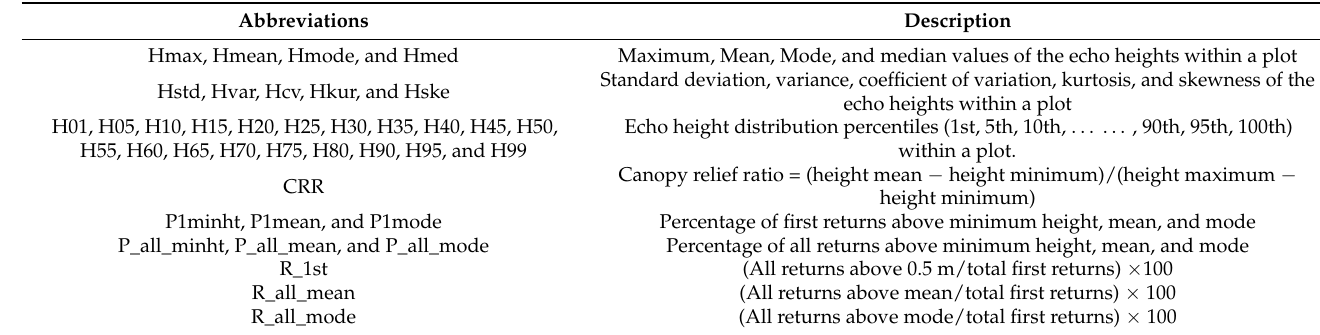
Table 2. Description of plot-level metrics derived from lidar data.